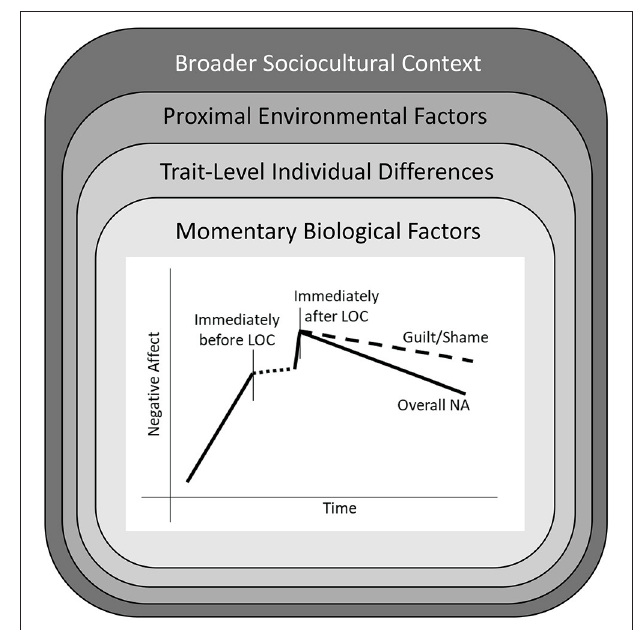
FIGURE 2 | A revised affect-focused model of loss of control eating (LOC). The central figure shows the nomothetic pattern of changes in negative affect (NA) surrounding LOC found in a majority of experience sampling studies. This model is nestled within several layers of biological and environmental factors that could potentially alter the strength of NA-LOC associations. First are momentary biological factors, such as changes in hormone levels and blood sugar, that may alter reactivity to unpleasant events or stimuli. Second are trait-level individual differences that may moderate NA-LOC associations. Third are proximal environmental factors, such as interactions with peers or family members, that may increase (or decrease) NA, or affect the likelihood that NA will lead to LOC. Finally, individuals are encompassed by a broader sociocultural